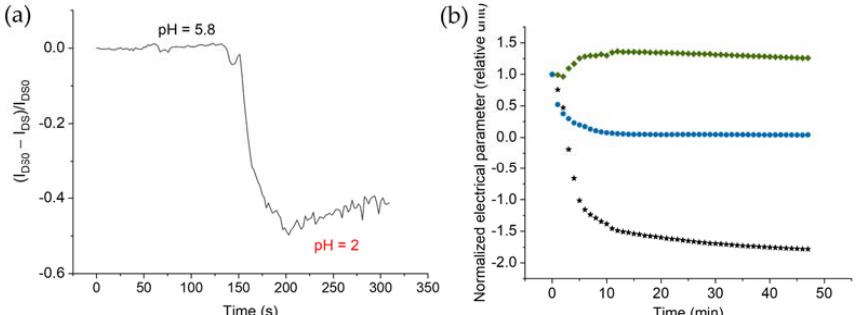
Figure 2. ( a ) Drain–source current at a constant voltage during HCl addition (transient measure- ments). ( b ) Drift of the normalized electrical parameters due to device degradation during the cycling measurements at pH = 5.8 in 0.1 M NaCl water solution: the threshold voltage (black stars), the off current (blue circles), the transconductance (green squares).